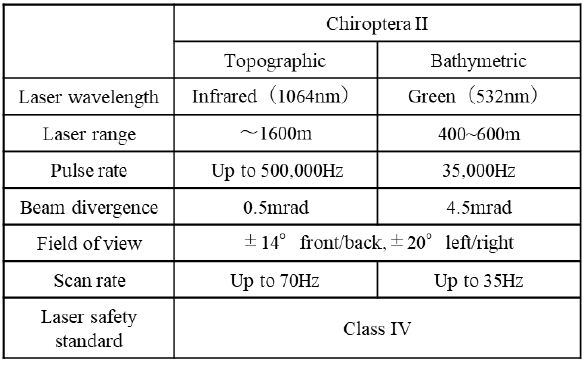
Table 1. Specifications of Chiroptera